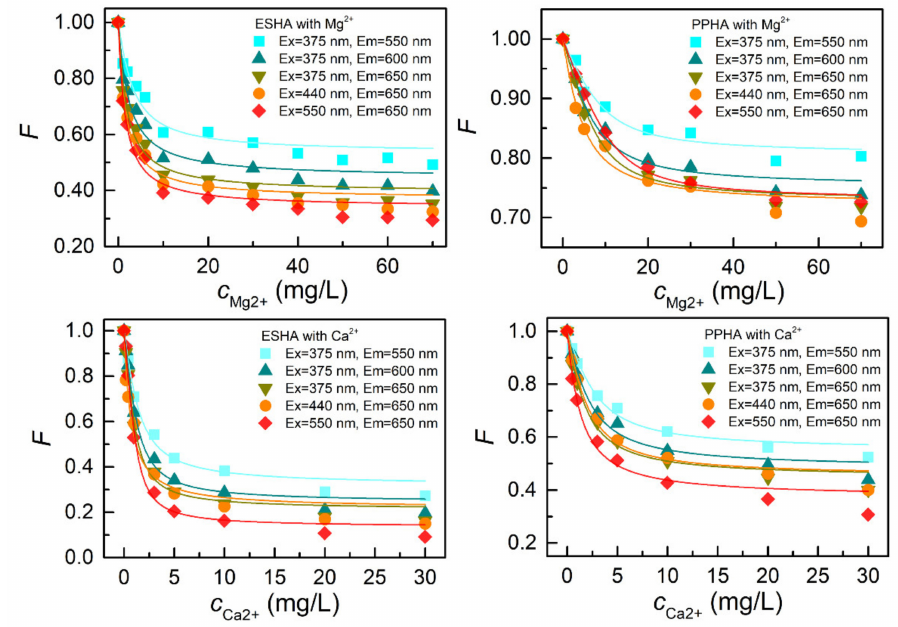
Figure 3. Changes of steady-state fluorescence intensity of ESHA (10 mg C/L) and PPHA (10 mg C/L) with Mg 2+ and Ca 2+ concentration. Curves represent experimental data fitted with the modified Ryan–Weber equation